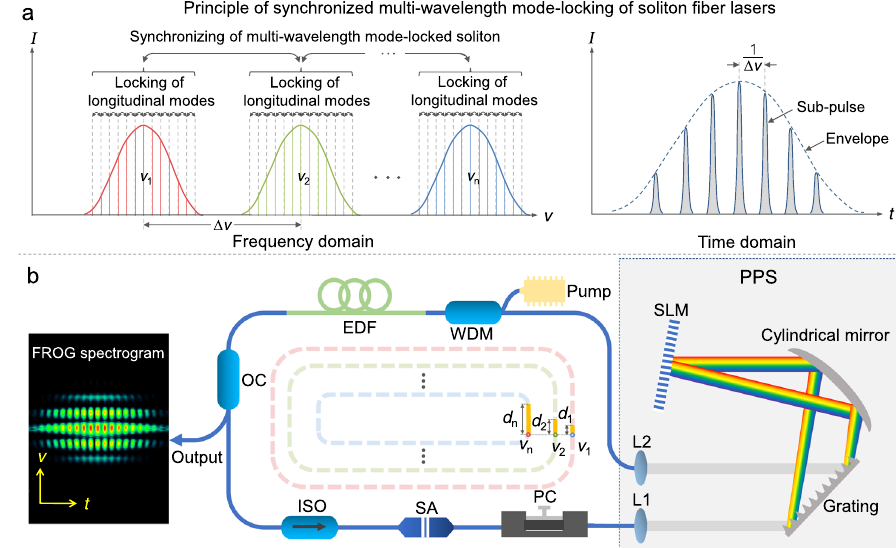
Fig. 1 Synchronized multi-wavelength mode-locking of soliton pulses. a Operation principle of synchronized multi-wavelength soliton fi ber laser in frequency and time domain. b Sketch of the mode-locked fi ber laser. WDM wavelength division multiplexer, EDF erbium-doped fi ber, OC optical coupler, PI-ISO polarization insensitive isolator, SA saturable absorber, PC polarization controller, PPS programmable pulse shaper, SLM spatial light modulator, L1 – L2 collimating lenses, FROG frequency-resolved optical gating. The group delay difference ( d 1 to d n ) among the multiple spectra ( ν 1 to ν n ) can be counteracted by introducing group delay with the SLM. The inset shows the typical FROG spectrogram of synchronized dual-wavelength mode-locked fi ber